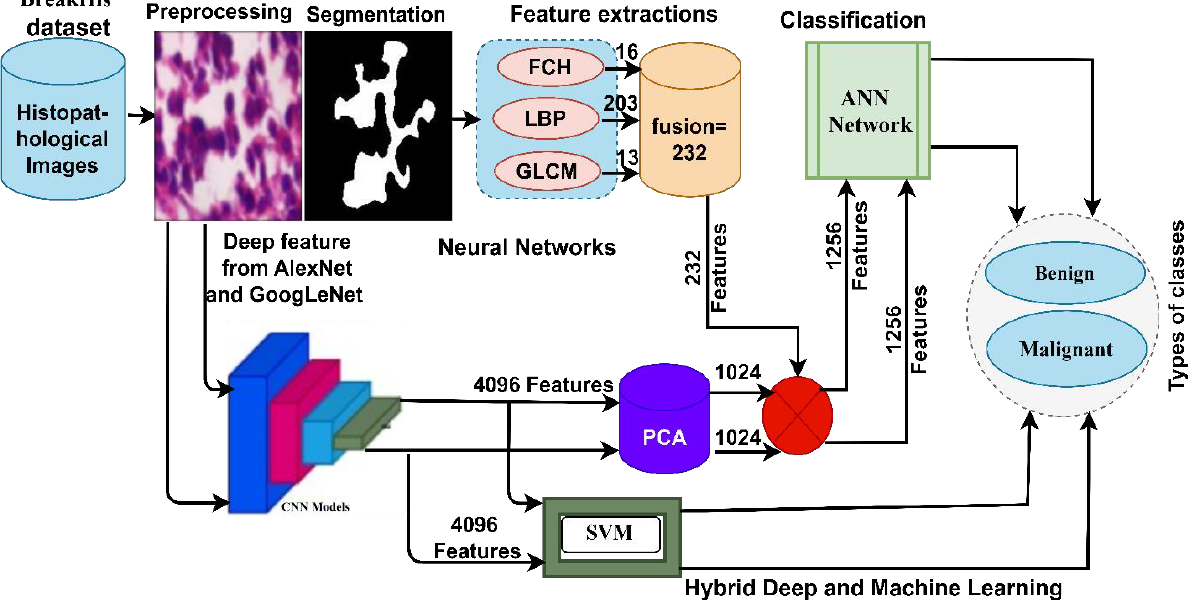
Figure 1. General structure for diagnosing HI of BC for the systems in this study.